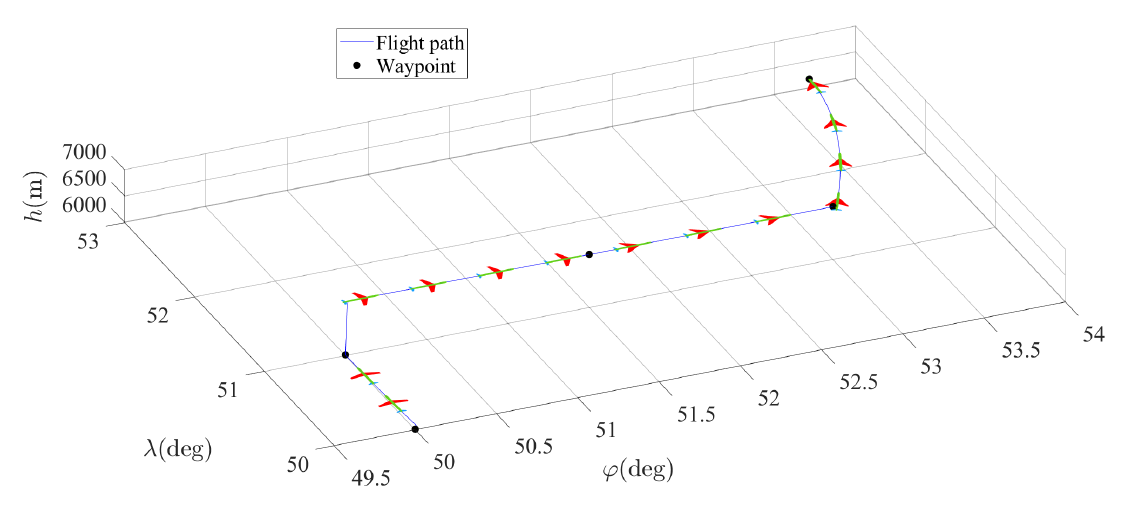
Figure 17. Flight path of the morphing aircraft with the morphing strategy proposed in Section 5.2.